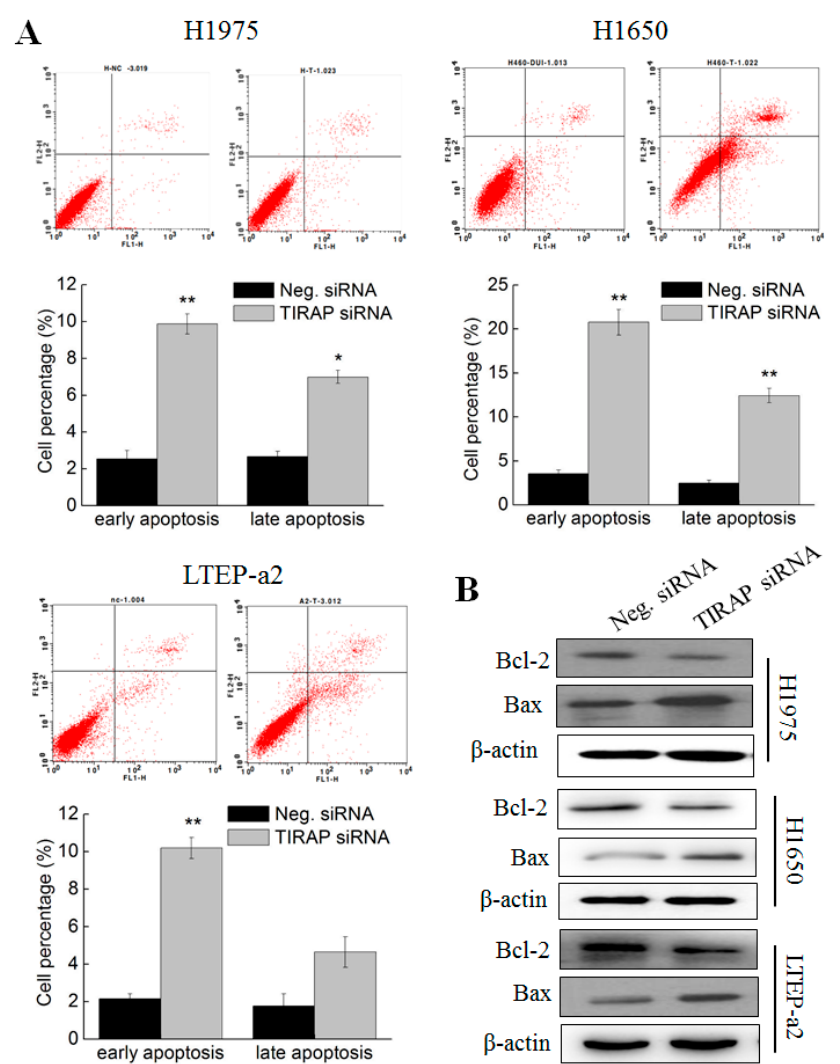
Figure 5. Knockdown of TIRAP expression induced apoptosis of non-small cell lung cancer cells. ( A ) Cell apoptosis analysis of H1975, H1650, and LTEP-a2 cells after transfection with Neg. and TIRAP siRNA. All cells were exposed to Neg. and TIRAP siRNA for 12 h, followed by culturing with complete RPMI-1640 media for 36 h before cell apoptosis analysis. The proportion of early and late apoptotic cells are shown in the histogram. ( B ) Western blot analysis of the expressions of Bcl-2 and Bax in H1975, H1650, and LTEP-a2 cells after transfected with Neg. and TIRAP siRNA. All cells were exposed to Neg. and TIRAP siRNA for 12 h, followed by culturing with complete medium for 48 h before protein extraction and Western analysis. TIRAP, Toll / interleukin 1 receptor domain-containing adaptor protein. Neg. siRNA, negative control siRNA. Bars represent mean ± SD. *, p < 0.05; **, p < 0.01.